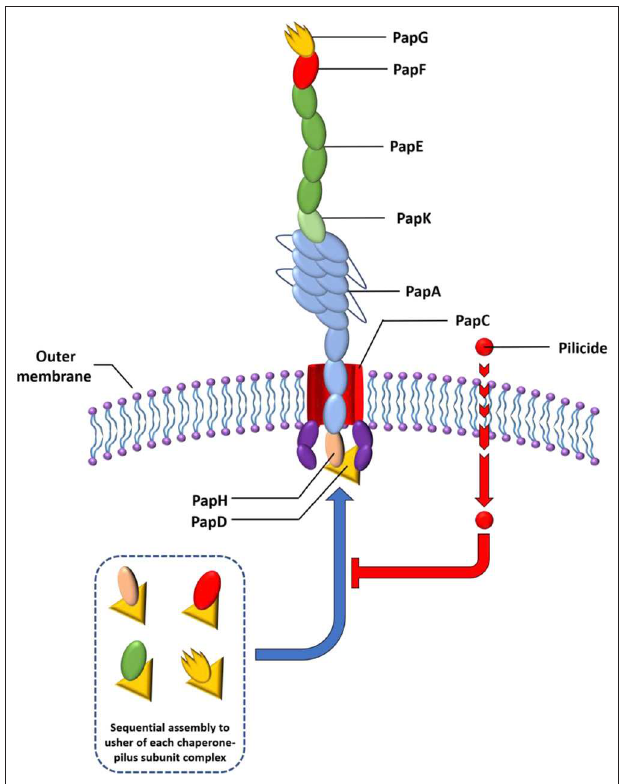
FIGURE 1 | Schematic representation of the P pili. The chaperones attached to the last subunit to be incorporated into each pilus are shown in yellow triangle. P pili are terminated at the outer membrane by the termination subunit, PapH. No such subunit is known in the Fim system. The pilicide bound to the chaperone-pilus subunit complex inhibit interaction with usher for further